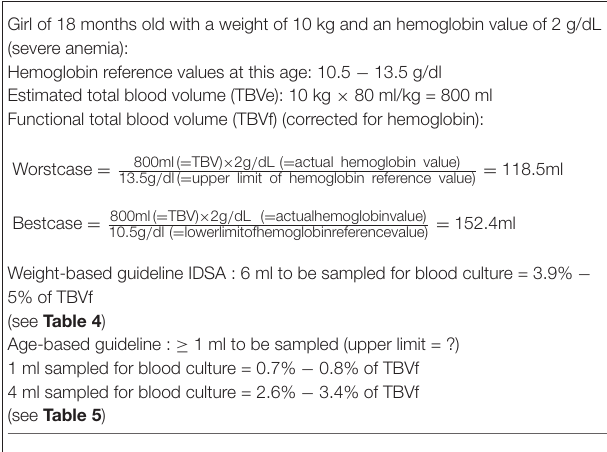
FIGURE 7 | Example of safe sampling in an 18-month old child with severe anemia caused by Plasmodium falciparum malaria [formulas used